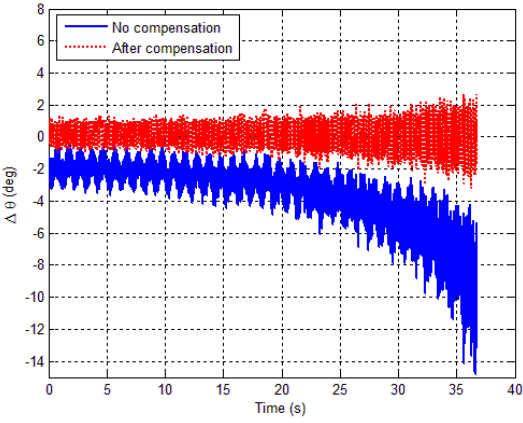
Figure 25. Pitch angle error versus time. Figure 26. Roll angle error versus time.